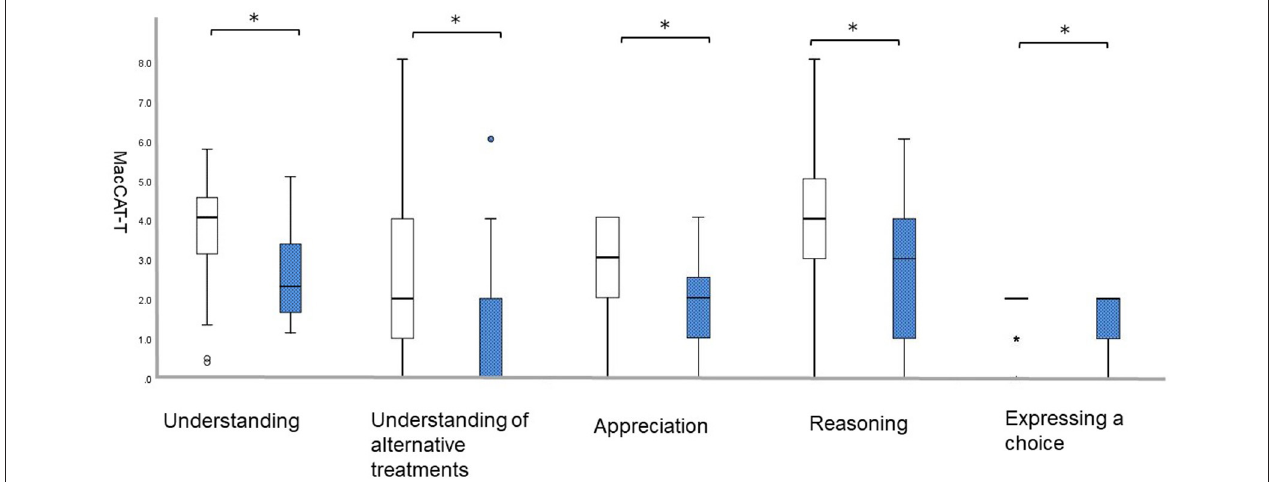
FIGURE 1 | Differences on the MacCAT-T subscales according to NPI-12. White bars represent patients with a score of 0 on anxiety; blue bars represent those with a score of 1 or higher on anxiety.; * p < 0.05. MacCAT-T, MacArthur Competence Tool for Treatment; NPI, Neuropsychiatric Inventory.